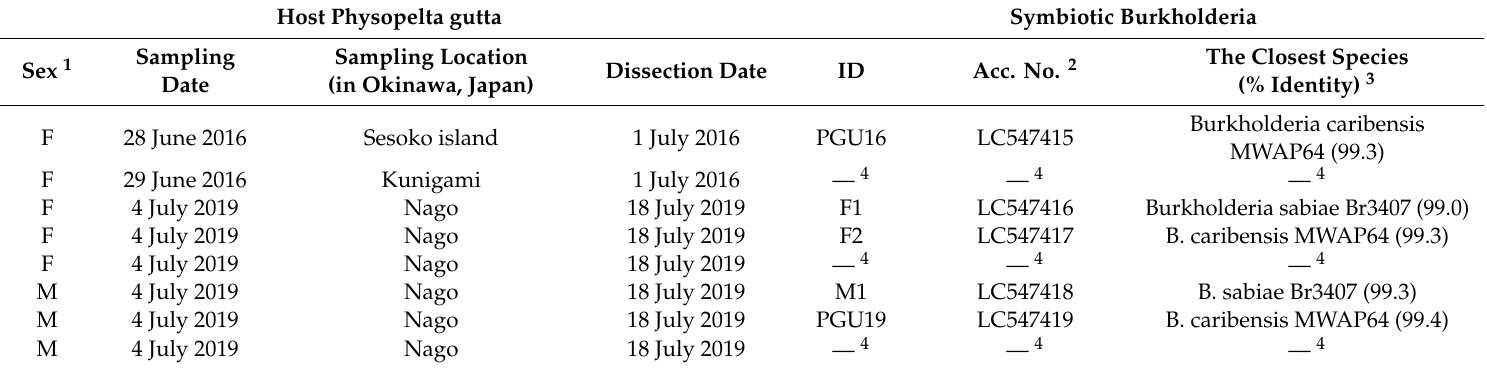
Table 1. Insect samples and isolated Burkholderia